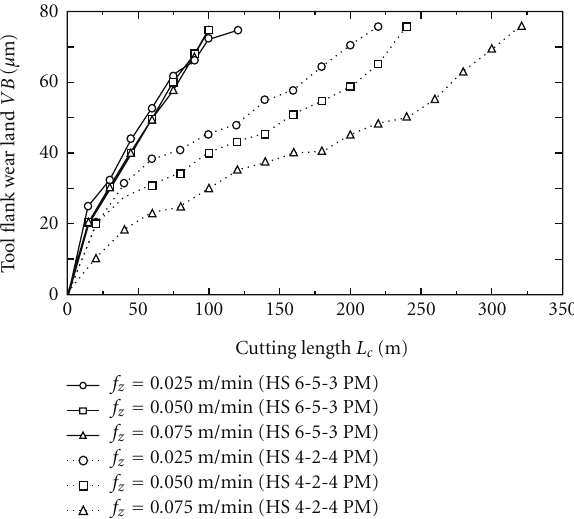
Figure 14: Influence of varied work piece material and fead per tooth on the tool flank wear land at v c ,e ff = 300 m/min.